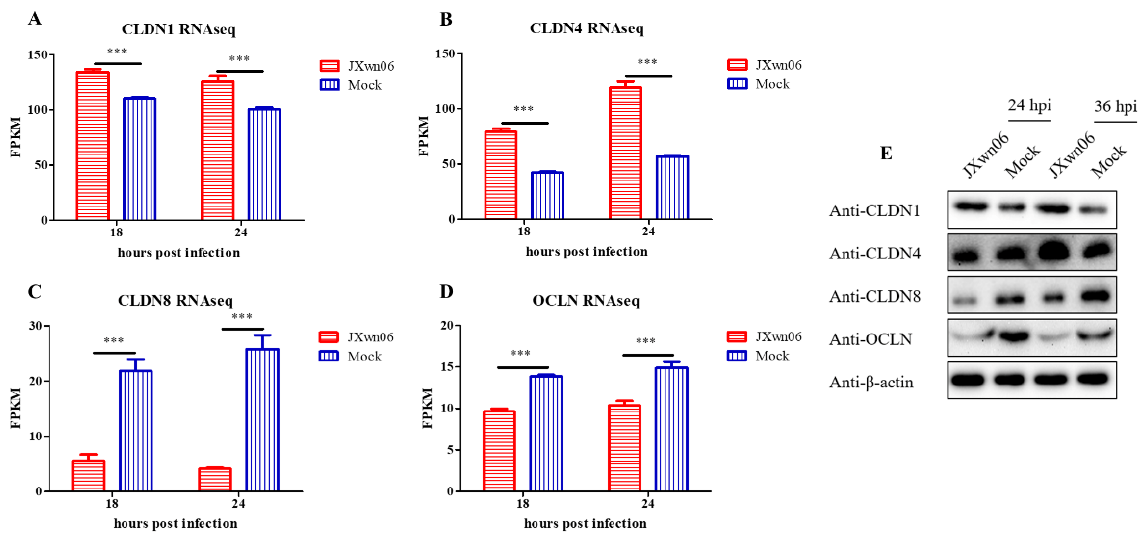
Figure 6. Interendothelial junction-associated genes in PMVECs are dysregulated upon interaction with HP-PRRSV-infected PAMs. RNA-seq data in fragments per kilobase million (FPKM) for four TJ genes, including CLDN1 ( A ), CLDN4 ( B ), CLDN8 ( C ), and OCLN ( D ), for comparison are presented. ( E ) Western blot analysis of CLDN1, CLDN4, CLDN8, and OCLN in co-cultured PMVECs at the indicated time points post inoculation. β -actin served as a loading control. The data are shown as means ± SD (standard deviation), n = 3 independent experiments. Asterisks indicate statistical significance (***, p < 0.001).